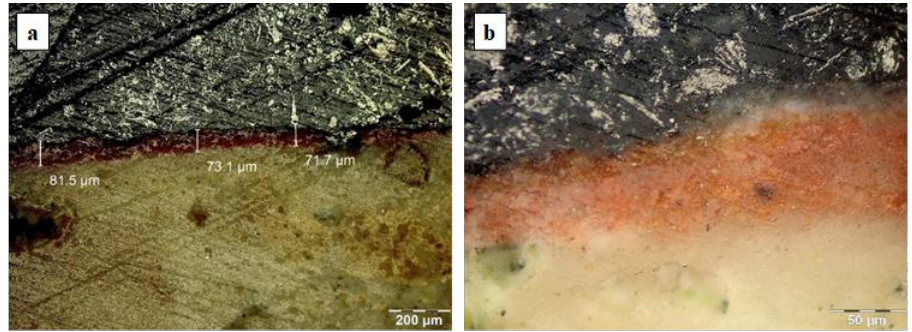
Figure 3. The pictorial layer in section through the fresco (OMPL).